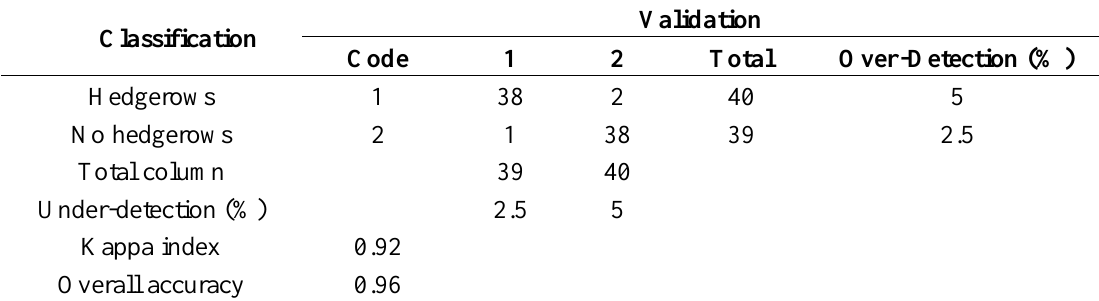
Table 1. Confusion matrix between the hedgerow classification derived from the TerraSAR-X image (lines) and the validation set (columns).